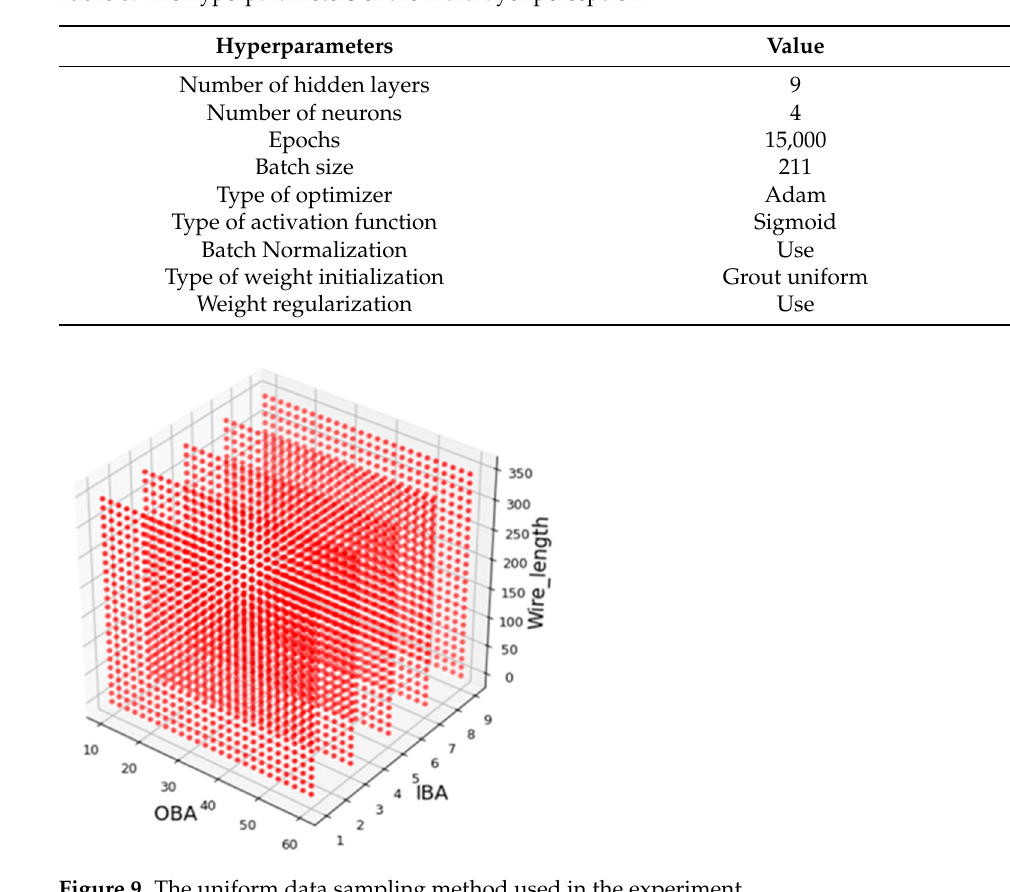
Table 8. The hyperparameters of the multilayer perceptron.